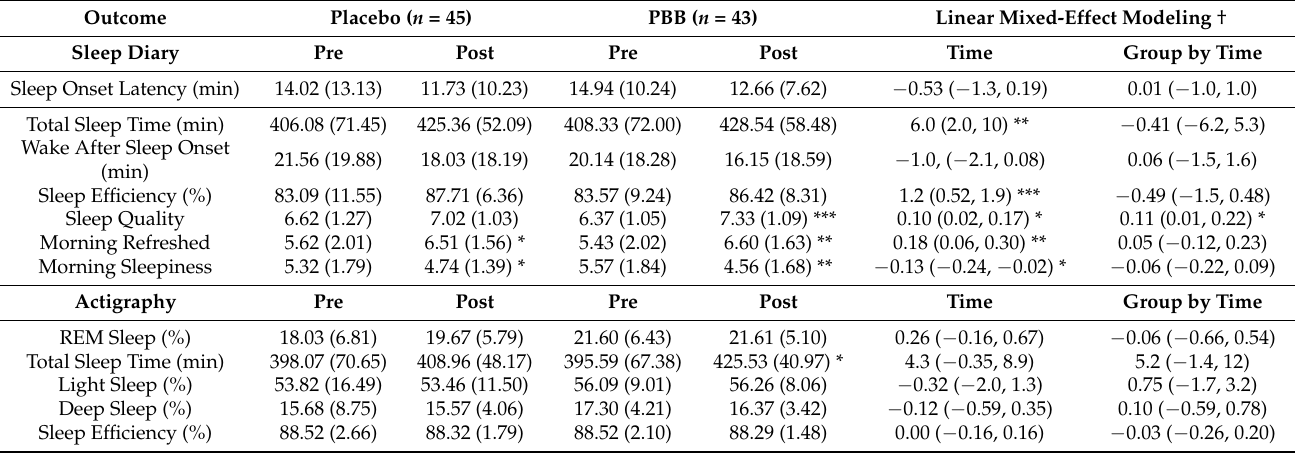
Table 2. Sleep diary and activity tracker outcomes. Table 4. Pre–post comparisons within and between groups on neurocognitive outcomes. Placebo PBB Linear Mixed-E ff ects Models †